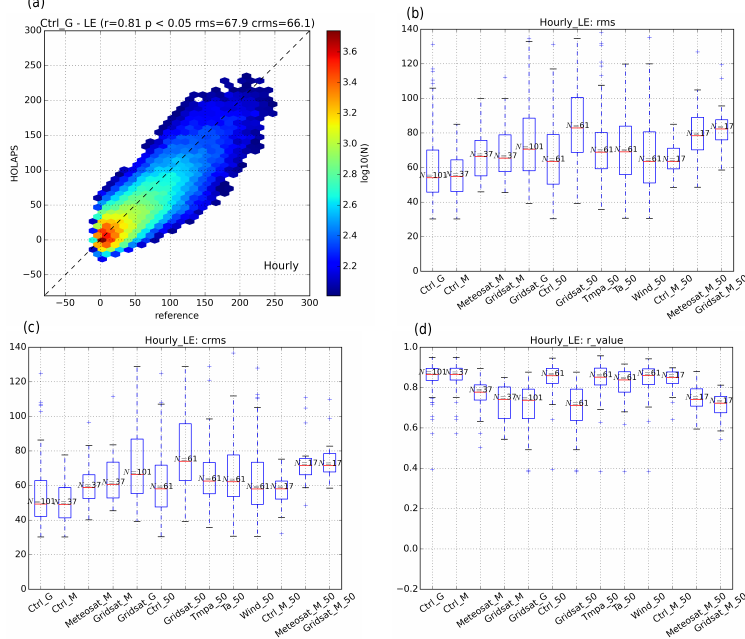
Figure E3. Error statistics for HOLAPS latent heat flux over daytime: (a) comparison using results from all stations and years, (b – d) box plots of validation statistics that are calculated at each